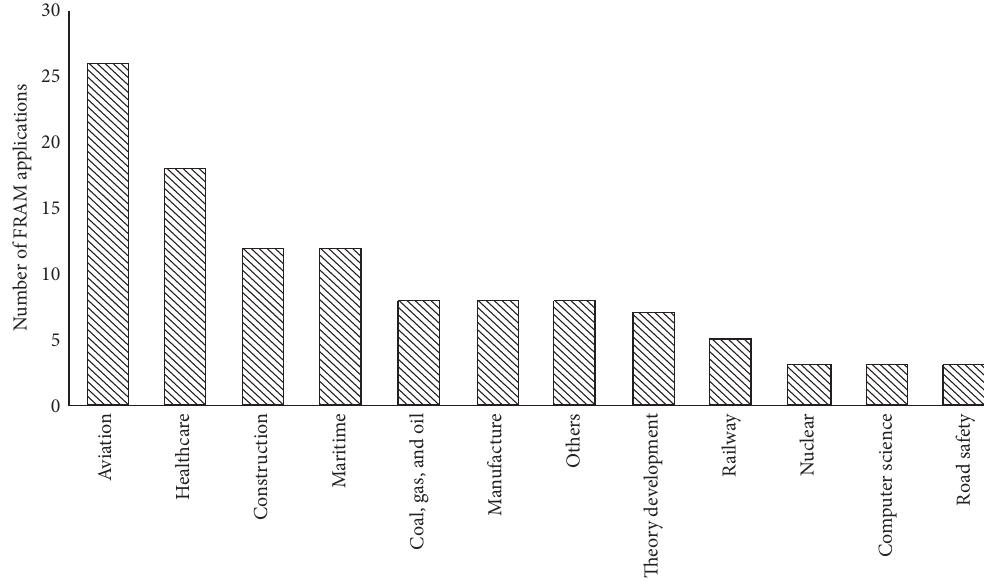
Figure 5: The number of FRAM applications across